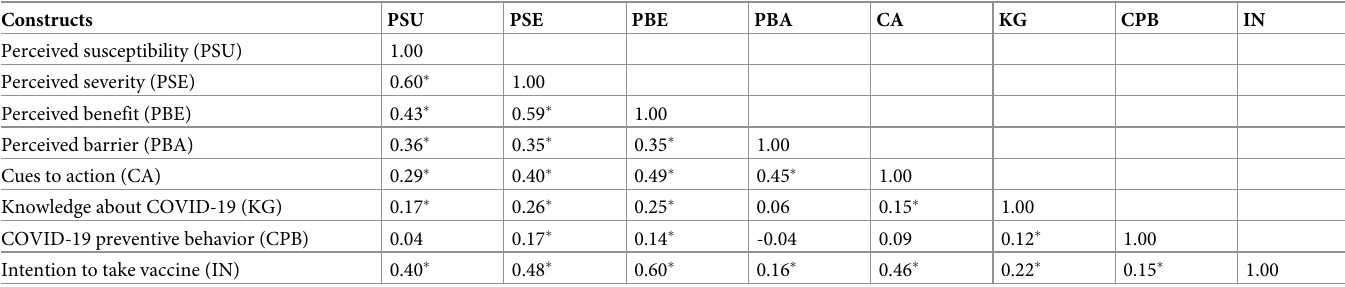
Table 4. Spearman’s rank correlation of health belief on intention to receive COVID-19 vaccine among school teachers in Gondar city, North West Ethiopia,